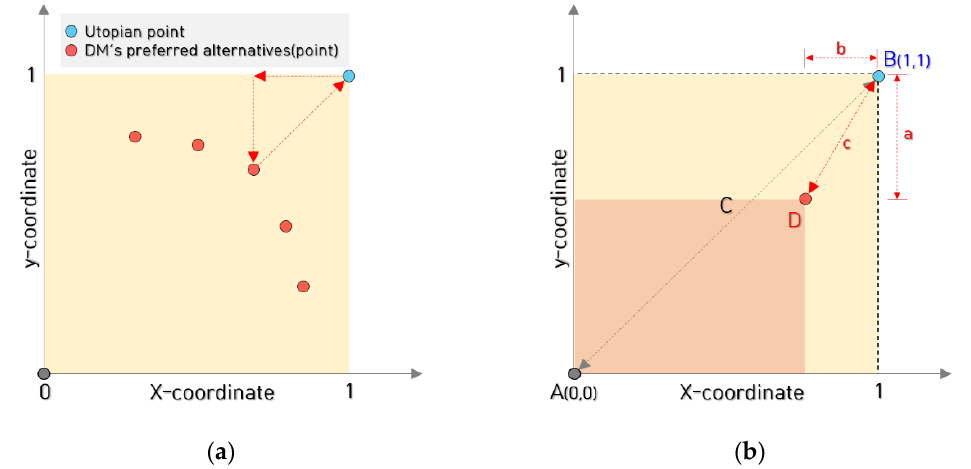
Figure 4. Concept of utopian approach. ( a ) Utopian approach method using ( b ) the Euclidean distance of the two-vector concept [42].